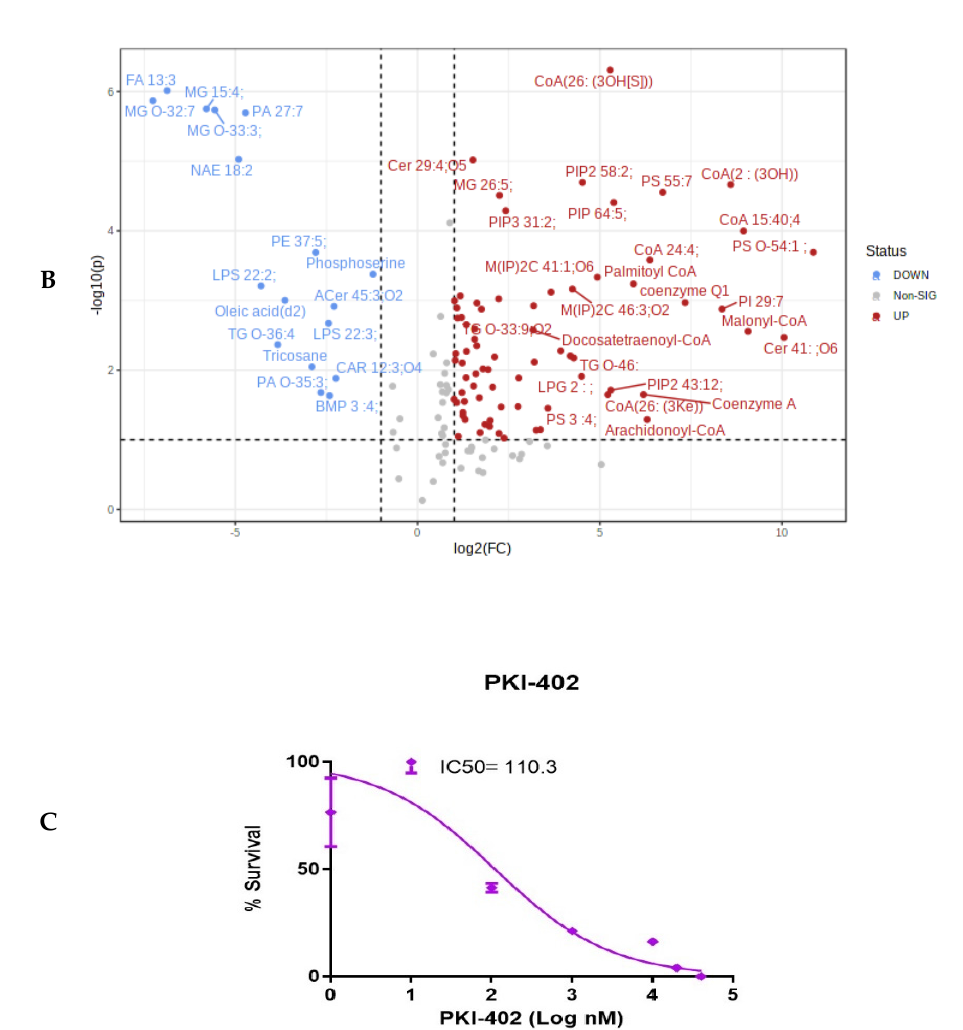
Figure 2. Metabolomic analysis of MV4-11 cells vs. ABT199-R cells. ( A ) The metabolic heatmap profile of differentially accumulated metab olites between sensitive MV4-11 and resistant ABT199-R. ( B ) Volcano plots of metabolic differentiation between MV4-11 and ABT199-R. ( C ) ABT199-R cells were treated with several concentrations of PKI-402 for 48 h and assessed with cell titer blue viability assay. The curve indicates the IC50 value.